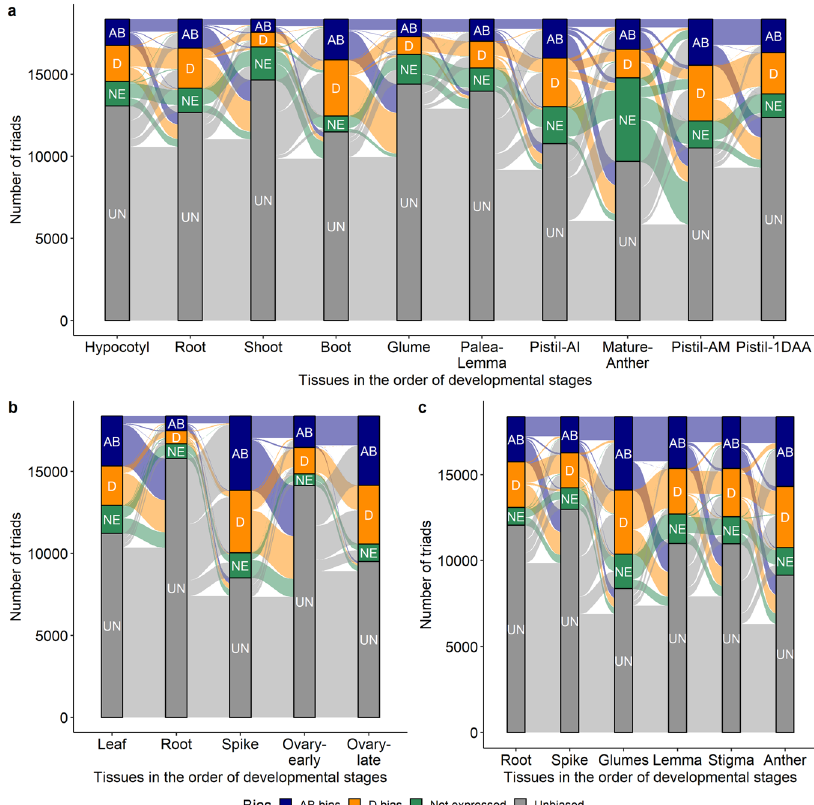
Fig. 7 Expression bias trends of the triads across tissues. Alluvial plots representing the expression bias trends of the triads across the tissues in the ( a ) SHW-C66 ( b ) Landrace Chinese Spring and ( c ) Cultivar Azhurnaya; AB bias (AB), represented by navy blue bars: triads signi fi cantly biased towards the AB subgenome; D bias (D), represented by dark orange bars: triads signi fi cantly biased towards the D subgenome; Not expressed (NE), represented by green bars: the homoeologues of the triads are not expressed; Unbiased (UN), represented by gray bars: no signi fi cant expression bias